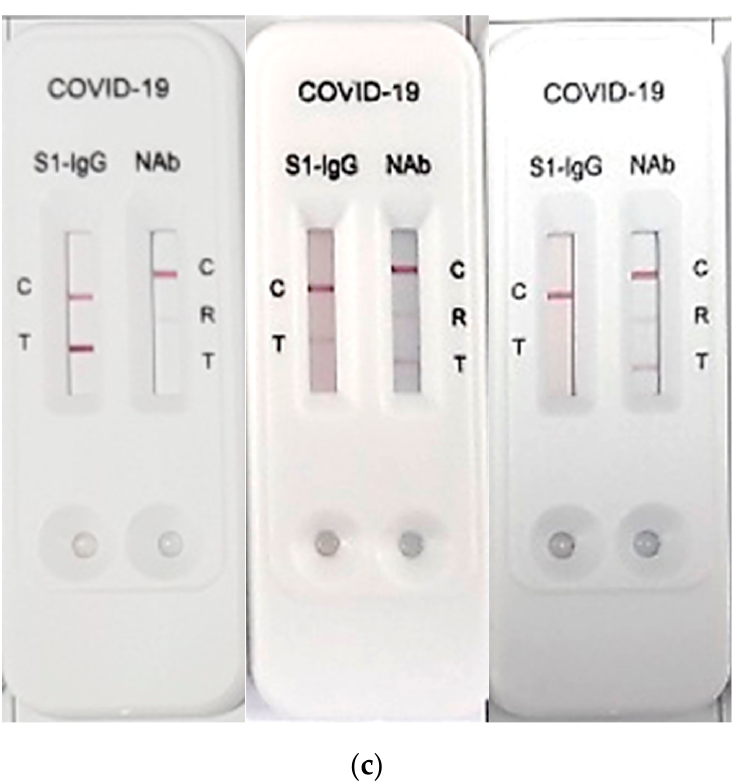
Figure 1. Schematic diagram and images of the RapiSure COVID-19 S1 RBD IgG/Neutralizing Ab Test. ( a ) S1 RBD IgG; ( b ) neutralizing antibody; and ( c ) images of the RapiSure COVID-19 S1 RBD IgG/Neutralizing Ab Test using representative serum samples with positive, weakly positive, and negative results from left to right.